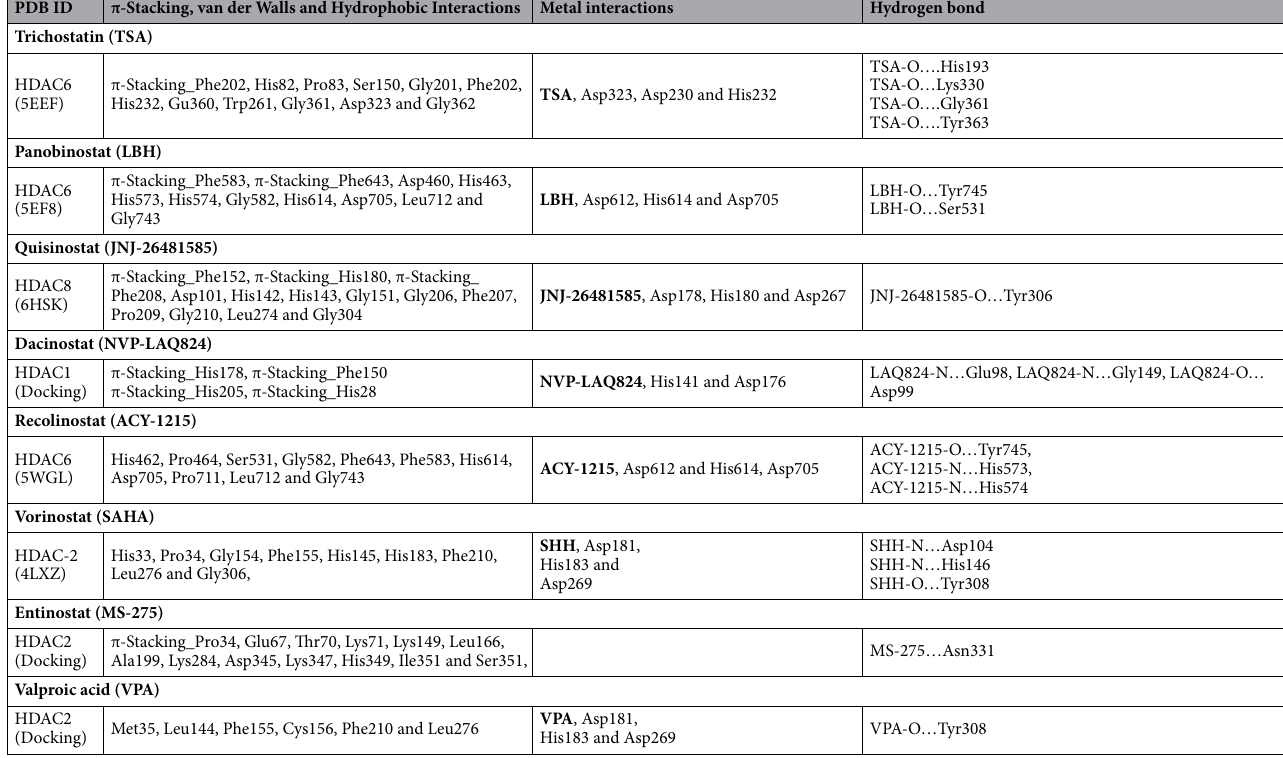
Table 7. The combined protein–ligand interactions profiles of training set compounds obtained from the PLIP server and